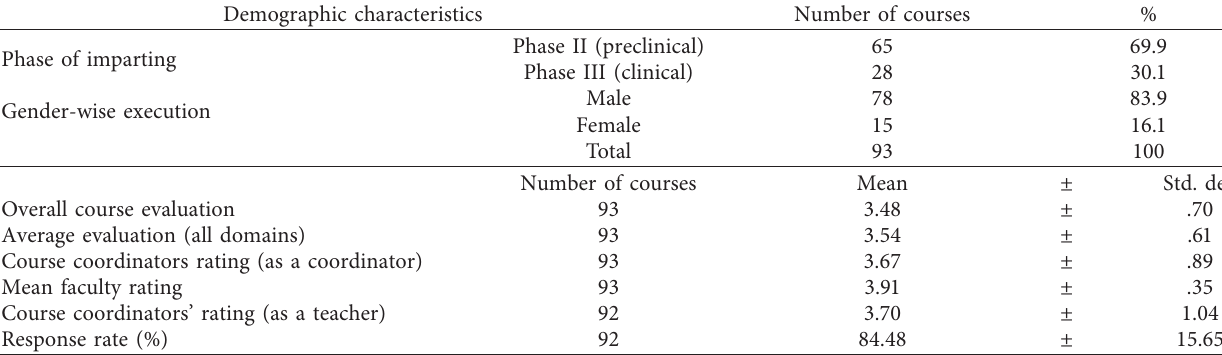
Table 2: Demographic characteristics of courses.